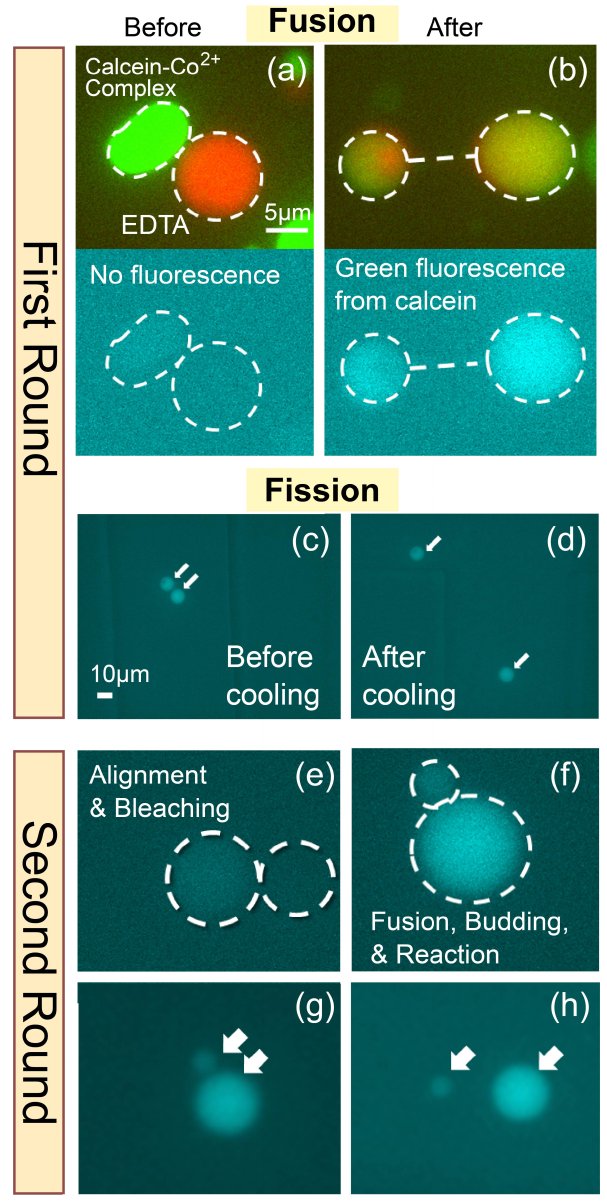
Figure 4. Fluorescence micrographs showing two successive rounds of vesicle fusion (mixing), reaction, and budding/ fission (aliquoting). The 5- m m scale bar in panel (a) also applies to panel (b) and to panels (e)–(h), whereas the 10- m m scale bar in panel (c) also applies to panel (d).